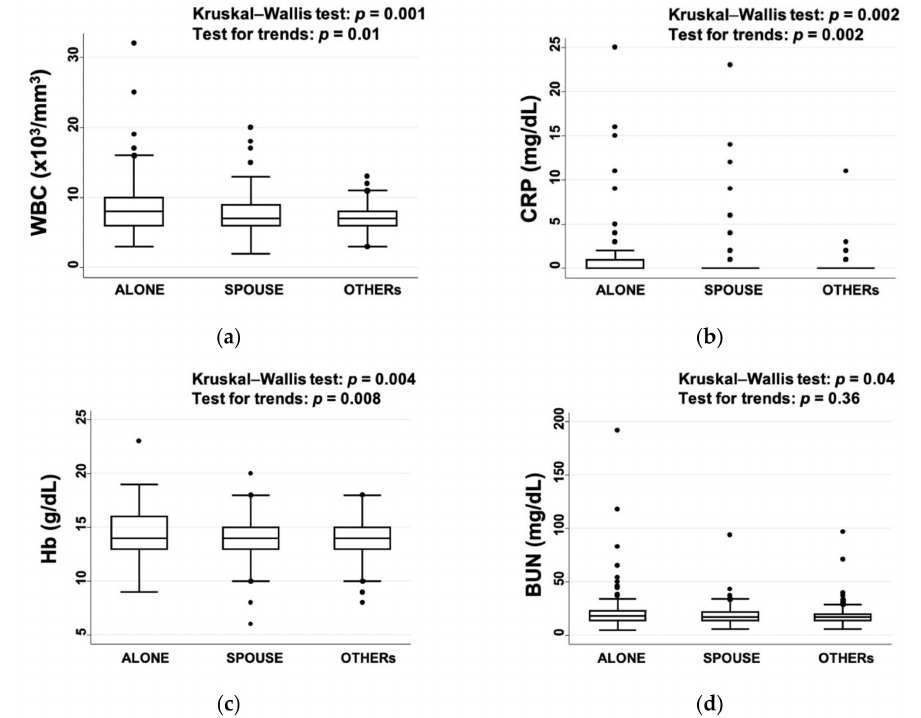
Figure 3. Laboratory data at admission: ( a ) white blood cells (WBC), ( b ) C-reactive protein (CRP),